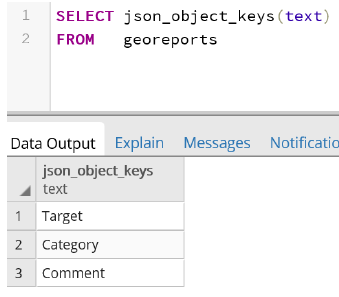
Figure 10. The JSON keys composing the attribute text of table georeports .